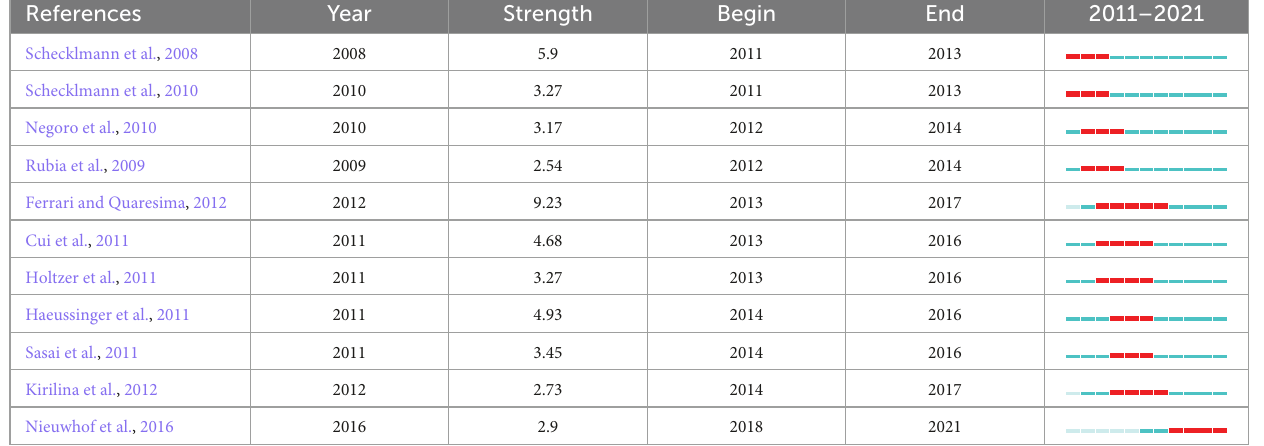
TABLE 6 Top 11 co-cited references with the strongest citation